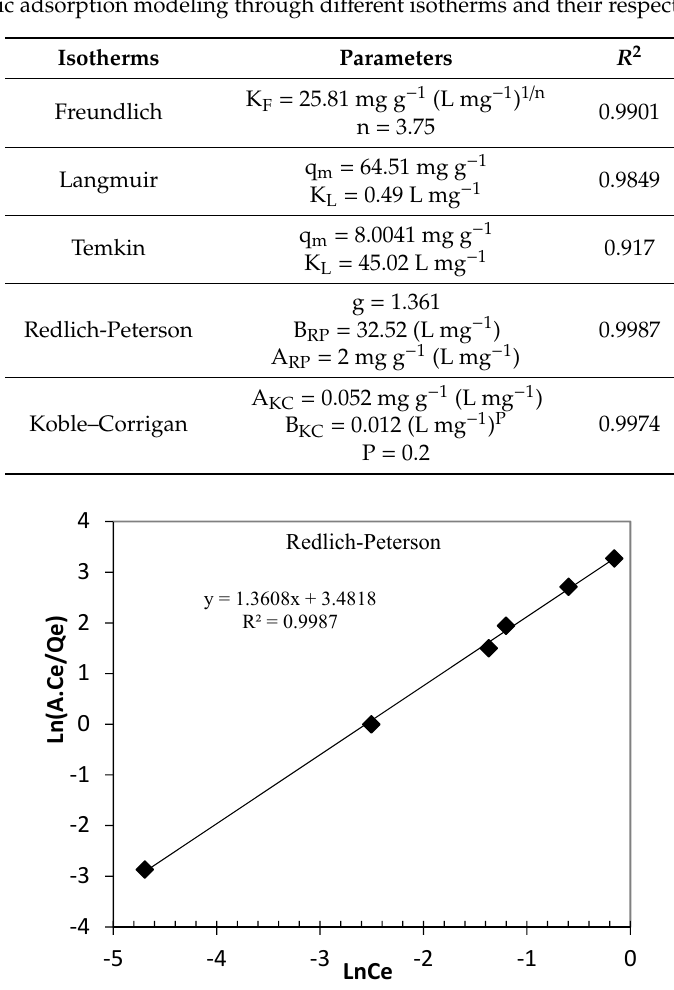
Table 5. Arsenic adsorption modeling through di ff erent isotherms and their respective parameters.